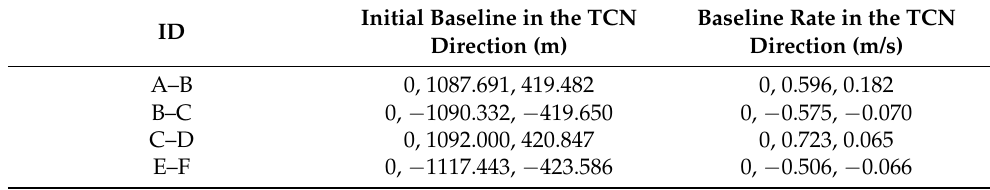
Figure 3. The study area considered in this paper: ( a ) the geographical location of the study area, ( b ) enlarged views of areas A to D, and ( c ) enlarged views of areas E to F. In ( b , c ), the white wireframes indicate the coverage of the SAR images, the green triangles denote GCPs, and the red points are the ICESat track. Table 2. Parameters of experimental